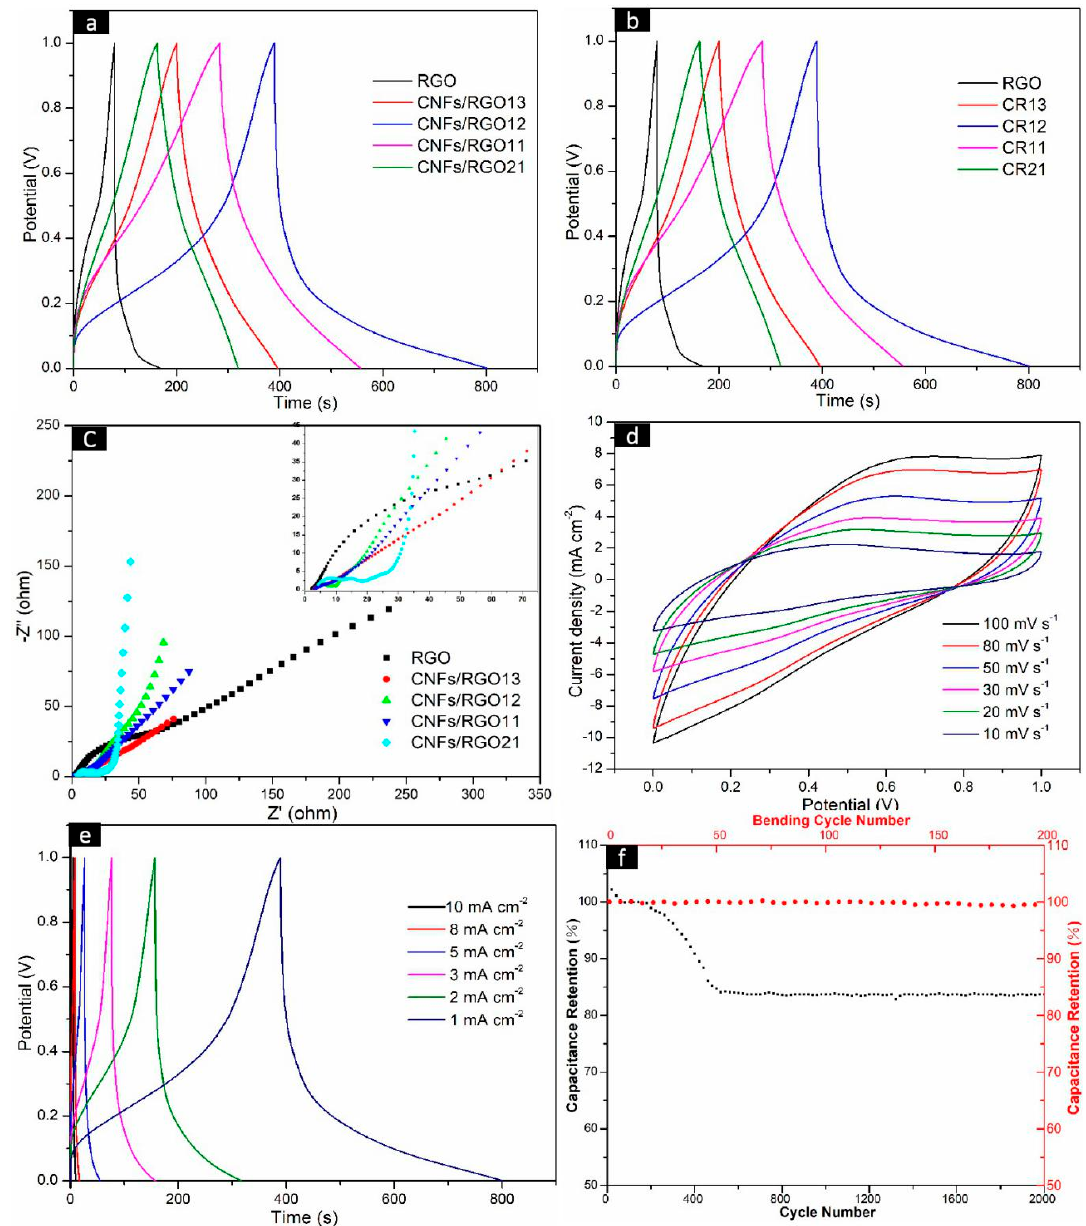
Figure 7. Electrochemical performance of the RGO and CNF/RGO composite film electrodes in a liquid electrolyte aqueous solution of 1 M H 2 SO 4 . ( a ) The galvanostatic charge/discharge (GCD) curves of the RGO and CNF/RGO films at 5 mV s − 1 . ( b ) Areal capacitance of the RGO and CNF/RGO film electrodes at different current densities. ( c ) The Nyquist impedance plots of the RGO and CNF/RGO film electrodes. ( d – f ) Cyclic voltammetry (CV) curves, GCD curves, and stability of the CNFs/RGO 12 film electrode.